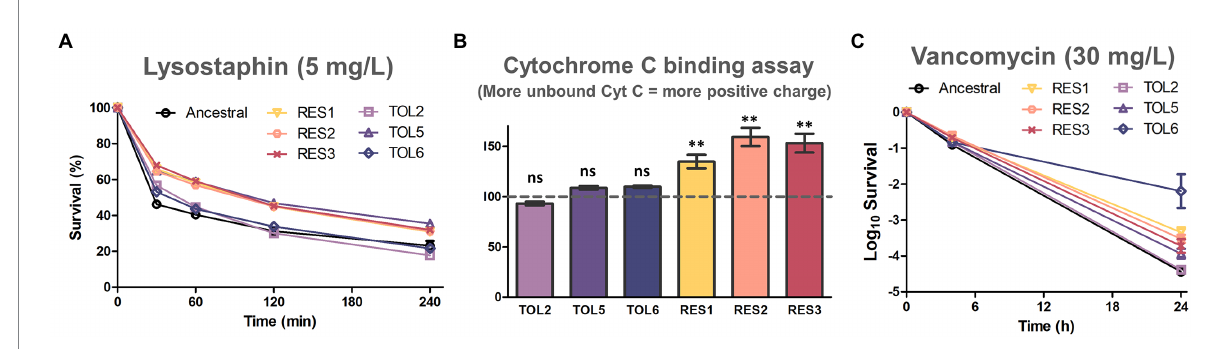
FIGURE 5 Assays to assess cell wall modifications on the evolved strains. (A) Lysostaphin lysis assay in the ancestral strain and evolved strains. Cells were treated with 5 mg/l of lysostaphin, incubated at 37 ° C, and the decrease in OD 600 was monitored over time (mean ± s.e.m., n = 3). (B) Binding of positively charged cytochrome c to the ancestral and evolved strains. The y-axis shows the percentage of unbound cytochrome c in comparison with the ancestral strain (marked with the horizontal dashed line; mean ± s.e.m., n = 3). Significance of difference from the ancestral strain: ns, not significant, ** P < 0.01 (two-tailed t -test with unequal variances). (C) Time-kill curve of exponential phase ancestral strain and evolved strains with 30 mg/l of vancomycin (mean ± s.e.m., n =